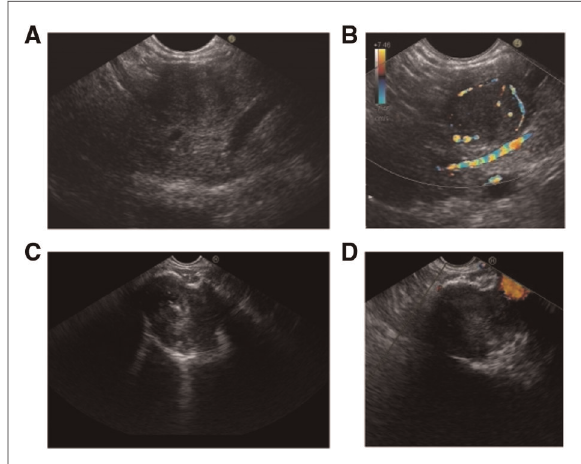
FIGURE 2 Characteristics of pNET and SPT in EUS. ( A,B ) pNET in a 54-year-old man with no physical discomfort. A homogeneous and hypoechoic lesion with a clear border was found in the pancreatic body. CDFI indicated the distinct peritumoral blood fl ow. ( C,D ) SPT identi fi ed in a 36-year-old woman during physical examination. A heterogeneous and hypoechoic lesion with a clear border was identi fi ed in the pancreatic neck. CDFI showed no signi fi cant blood fl ow signal. Hyperechoic calci fi cation was observed in the lesion. pNET, pancreatic neuroendocrine tumor; EUS, endoscopic ultrasound; SPT, solid pseudopapillary tumor; CDFI, color Doppler fl ow imaging.